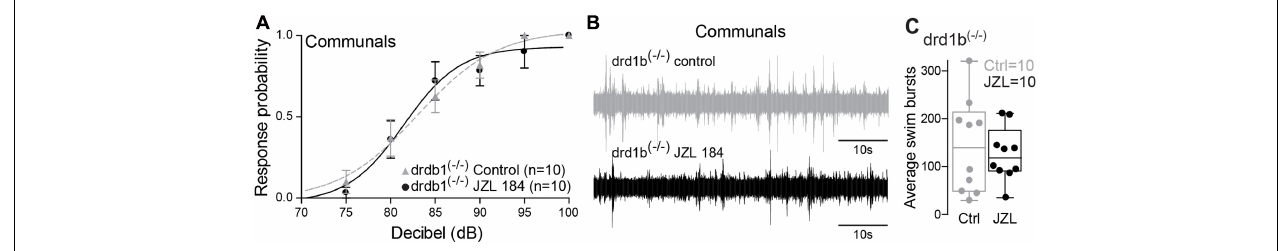
FIGURE 5 | drd1b expression is socially regulated and necessary for status-dependent ECS regulation of escape and swim circuits. (A) Probability of startle escape response of drd1b ( − / − ) communal zebrafish before (control) and after injection of JZL184. (B) 1 min recording of far field-potentials of spontaneous swimming activity before (control) and after JZL184 injections for drd1b ( − / − ) communal zebrafish. (C) Average number of swim bursts per 1 min for drd1b ( − / − ) communal fish ( n = 10) before and after JZL184 injection.